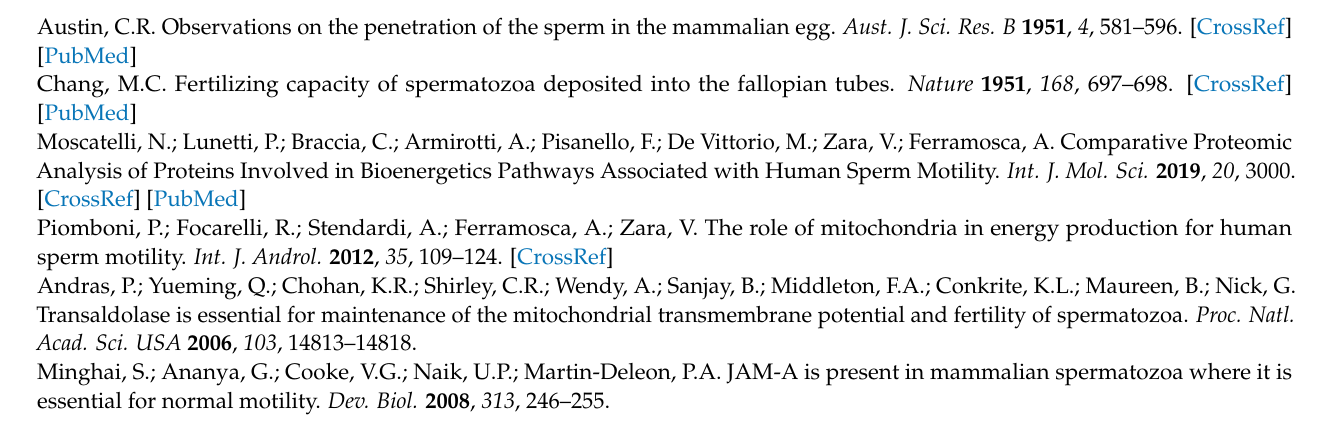
Table S1: Primer sequences for RT-qPCR; Table S2: Buffalo sperm proteome data; Table S3: Buffalo sperm differentially expressed proteomic